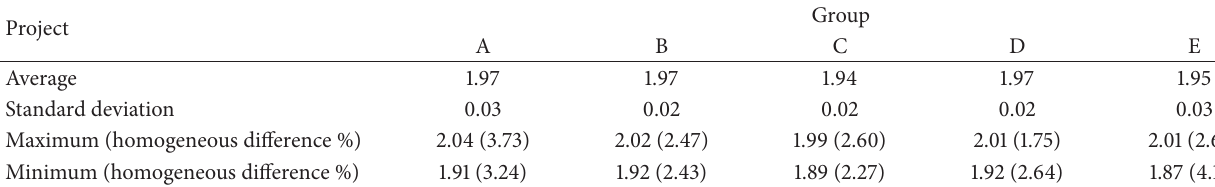
Table 3: Specific weights of soil specimens by group.